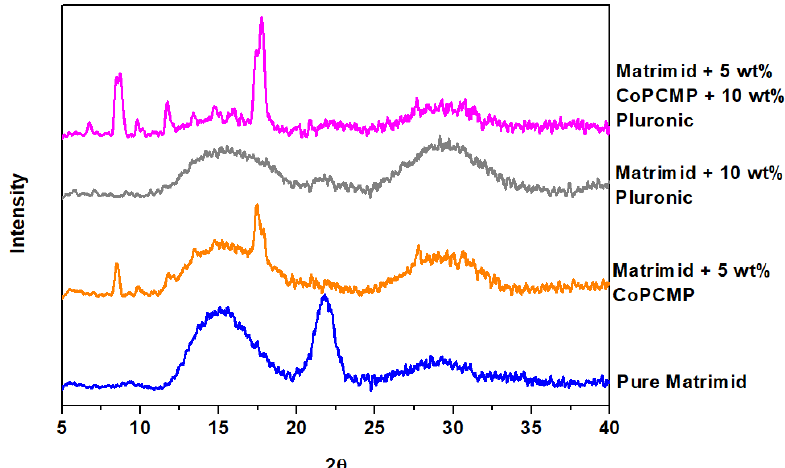
Figure 3. X-ray diffraction (XRD) patterns of neat (Matrimid), blended (Matrimid-Pluronic), and composite (Matrimid-CoPCMP and Matrimid-Pluronic-CoPCMP) membranes.